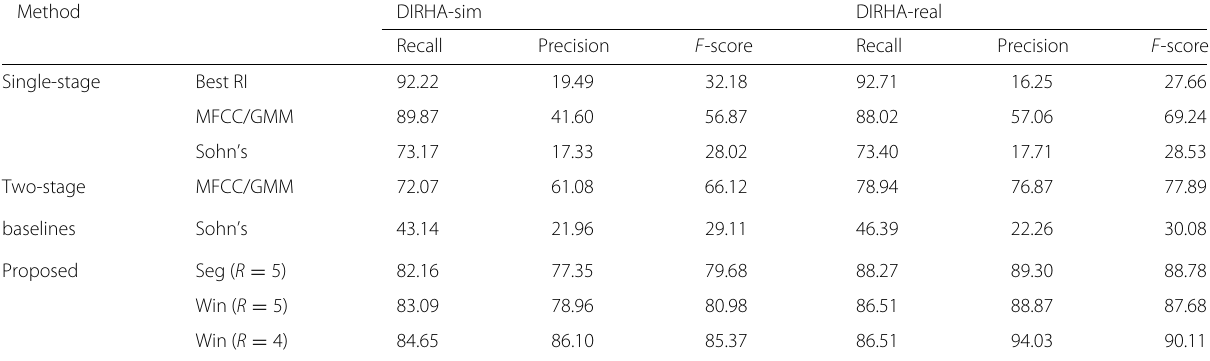
Table 6 Performance of various approaches for the full task of room-localized SAD on DIRHA-sim (left) and DIRHA-real (right)